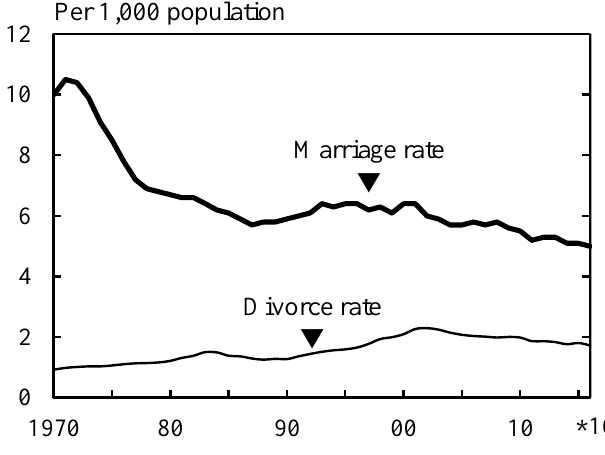
Changes in Marriage Rate and Divorce